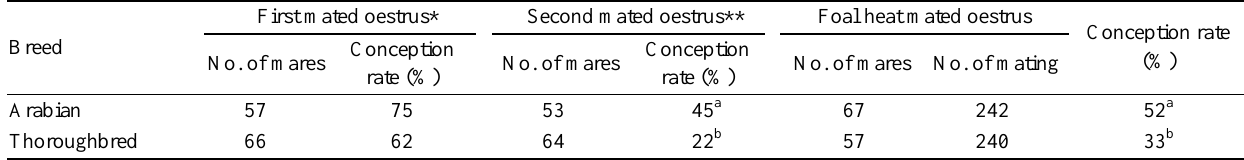
No. of mares No. of mating